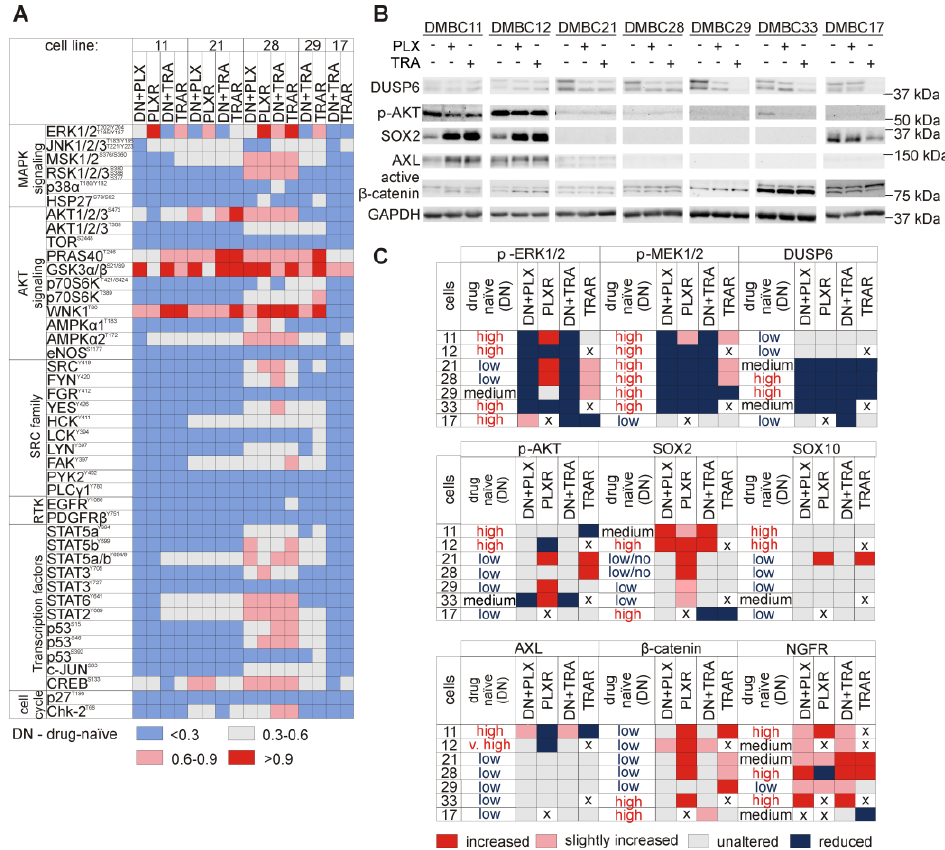
Figure 6. Comparison of vemurafenib (PLX)- or trametinib (TRA)-resistant cells with their drug-naïve counterparts shortly exposed to drugs revealed that several resistance-attributed alterations are already induced during short treatment. ( A ) Differential activation of key signaling molecules in drug-naïve (DN) melanoma cells after short treatment with drugs and drug-resistant (PLXR, TRAR) melanoma cells assessed by phospho-profiling. The graph shows relative levels of phospho-proteins, for which mean pixel densities were normalized to HSP60 level. Red and blue colors indicate high- and low-level of phosphorylation, respectively. ( B ) Western blot showing differences in the levels of DUSP6, SOX2, and AXL, and phosphorylation of AKT and dephosphorylated β -catenin between drug-naïve melanoma cells and cells shortly exposed to drugs. GAPDH was used as loading control; n = 3. ( C ) Color coded tables comparing expression and activity of proteins in melanoma cells during immediate response to drugs (DN+PLX; DN+TRA) or in stable drug-resistant cells (PLXR, TRAR) with respect to drug-naïve cells. Data are extracted from analysis of phospho-kinase array, immunoblotting, and flow cytometry presented in the figures in this report and elsewhere [22,27]. Changes in the level/activity of proteins are color coded (red, increase; blue, decrease; grey, no change).